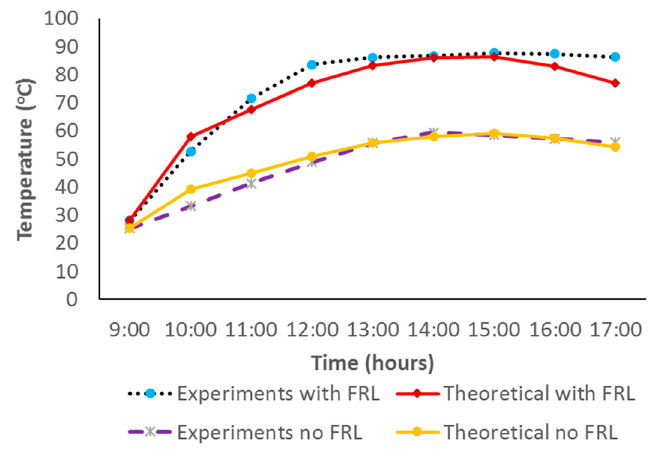
Figure 6. Hourly variation of experimental and theoretical values of water temperatures.